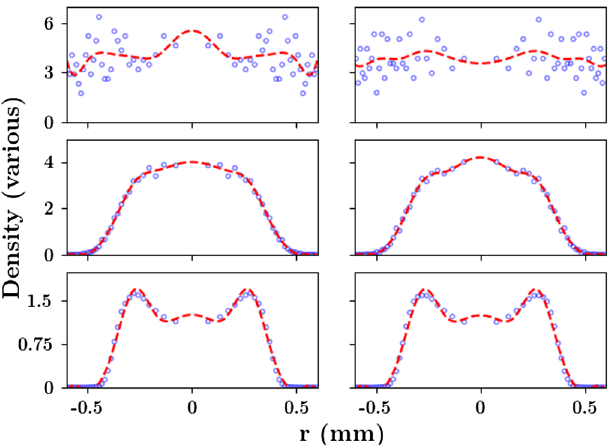
FIG. 3. Density near the z-median of simulated pancake bunches with transverse Gaussian profiles ( σ r ¼ 100 μ m) in an extraction field of 10 MV = m. Each row is the transverse radial density of a section of width σ z ≈ 0 . 4 μ m for different numbers of electrons, and columns represent 2 different initial conditions. Density was calculated at time 10 τ p where τ p ¼ ffiffiffiffiffiffi q m ϵ 0 2 π . The is the plasma frequency and where n ¼ N ne 2 πσ 2 r σ z number of electrons in each horizontal panel is different and equal to N ¼ 1000 (top), N ¼ 10 000 (middle), and N ¼ 100 000 (bottom). For the density at 10 τ p , 30 cylindrical shells of equal volume and length σ z partitioned the distribution out to 0.6 mm, and the numbers of electrons in each of these shells were used to calculate a density at the shell ’ s average radius. Due partially to the different numbers of electrons and partially due to the fact that the longer simulations, namely the simulation with N ¼ 1000 , resulted in significantly more electrons migrating out of the analysis region as a result of the initial velocity spread, the density scales are different for the three rows in the figure: 1 ð 0 . 1 mm Þ 3 for the top row, 0 . 1 for the middle row, and 1 for the ð 0 . 01 mm Þ 3 ð 0 . 01 mm Þ 3 bottom row. Red dashed lines represent splines of order 3 with 10 knots. Notice the clear presence of a shock for the case N ¼ 100 000 , an ambiguous shock at N ¼ 10 000 , and essen- tially noise at N ¼ 1000